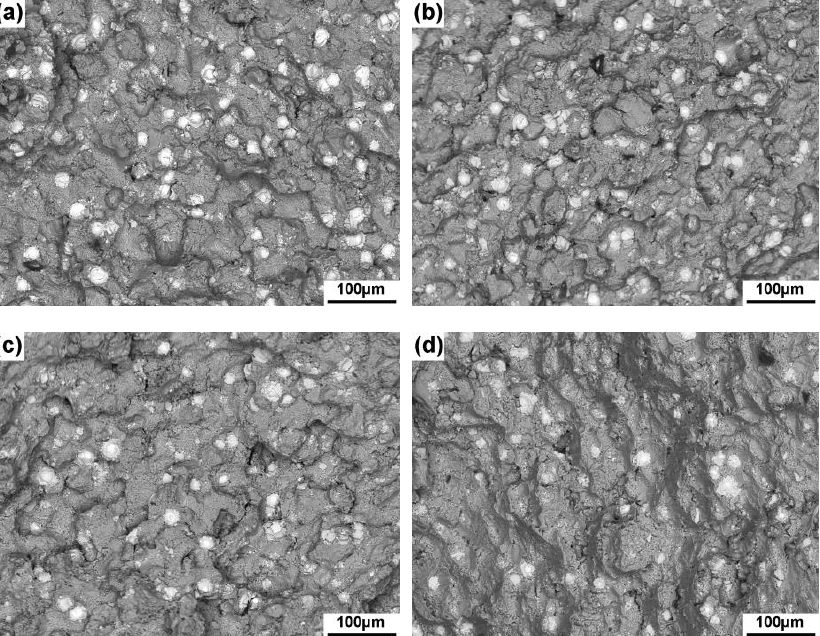
Figure 13. BSE images of fracture surfaces of the composites thixoformed under mold temperatures of